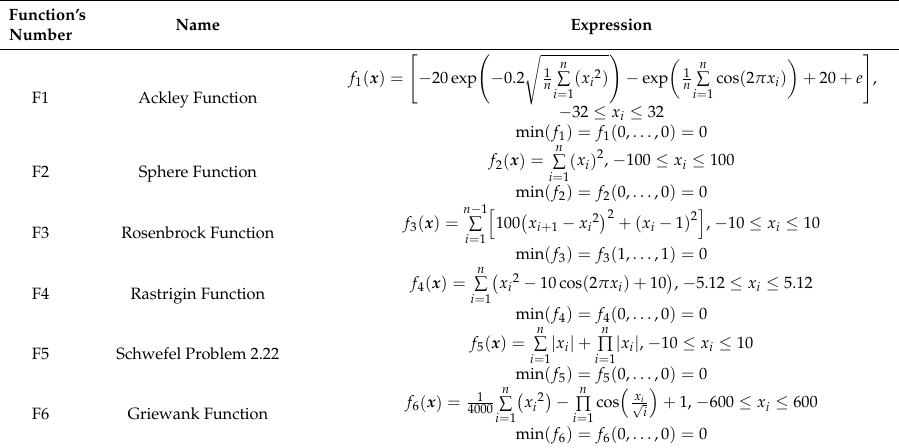
Table 3. Benchmark problem